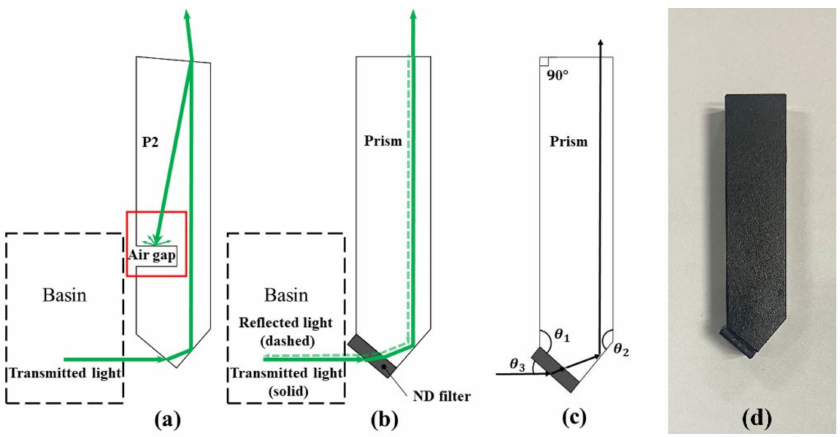
Figure 2. Schematic of different prisms and angle design of new prism. ( a ) P2. An air gap, as shown in the red box, is created inside the prism to prevent the light reflected onto the top surface of the prism from going back to the basin. However, diffused light, represented by the short green arrows, easily occurs in practice at the surface of the air gap when the surface is not smooth. ( b ) Designed prism structure. The solid green line and dashed green line represent the transmitted light and reflected light, respectively. ( c ) Angle design of new prism. These angles ( θ 1 , θ 2 , and θ 3 ) make the transmitted light vertical to the surface of the prism. ( d ) The manufactured new